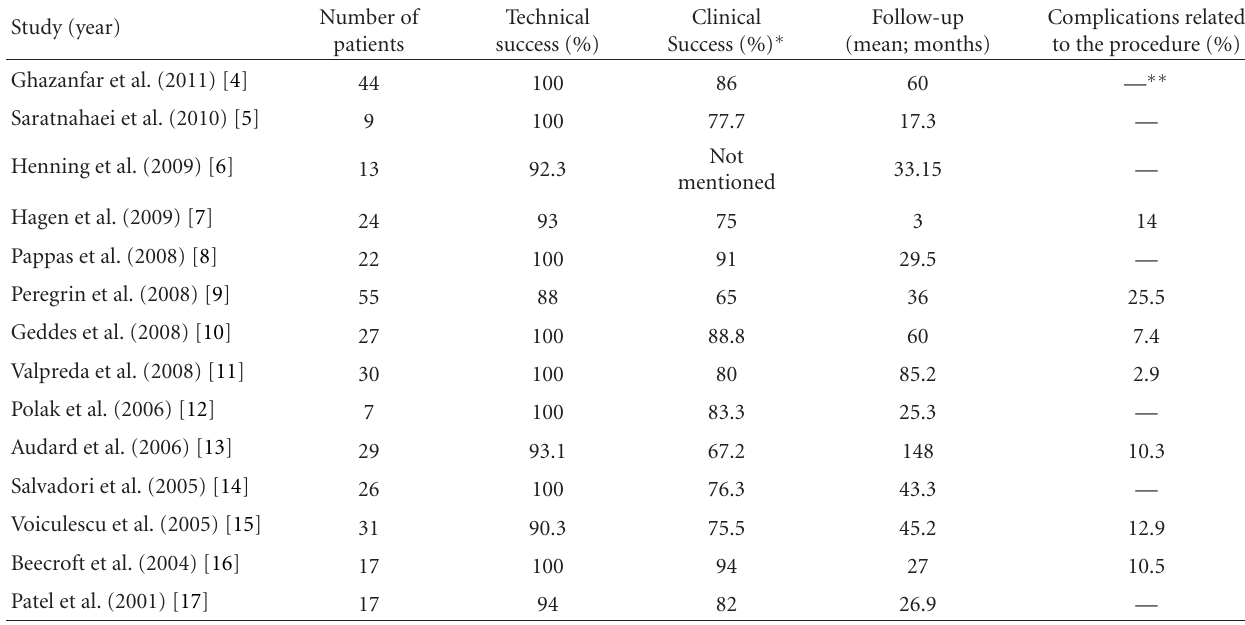
∗ Estimated as significant clinical benefit or good graft function during the whole follow-up period. ∗∗ No procedure-related complication